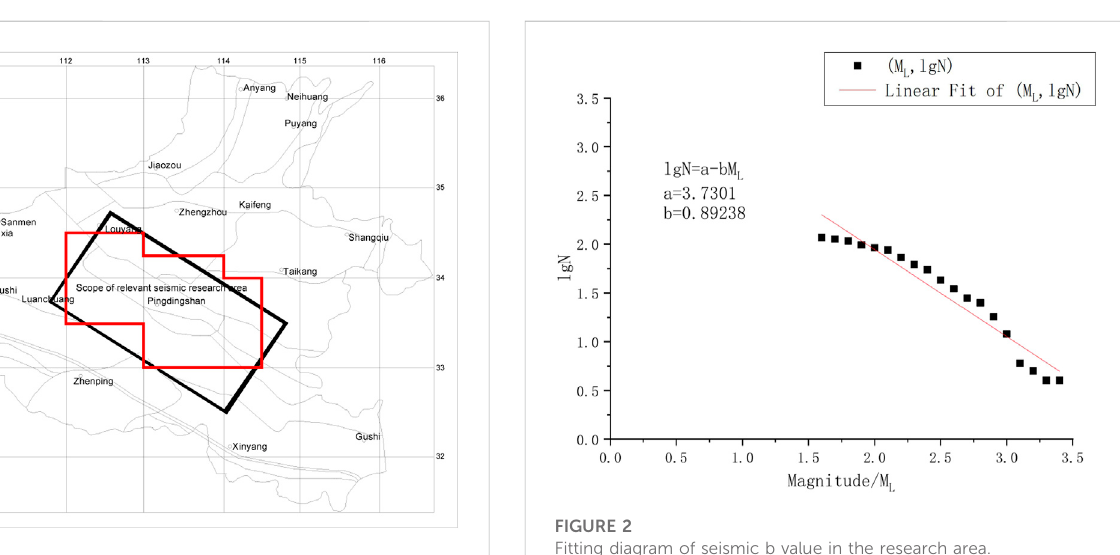
FIGURE 1 Scope of the research area.